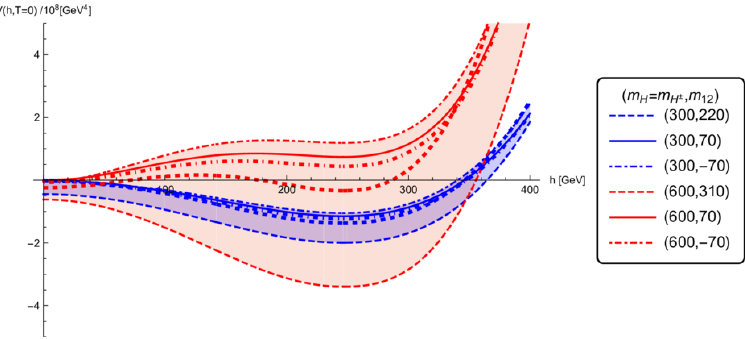
Figure 3 . The one-loop potential at zero temperature (including the CW potential and counter- terms). m H = m is assumed at two common scales 300 (blue) and 600 (red) GeV, m A = 50 GeV H (cid:6) is taken. The picture is negligibly modi(cid:12)ed for m A = 200 GeV. Three values of tan (cid:12) , tan (cid:12) = 1 (solid and dashed lines), tan (cid:12) = 10 (thick dashed lines) and tan (cid:12) = 20 (thick dotdashed lines) are shown for which m 2 is chosen such that none of quartic couplings exceeds the pertubativity 12